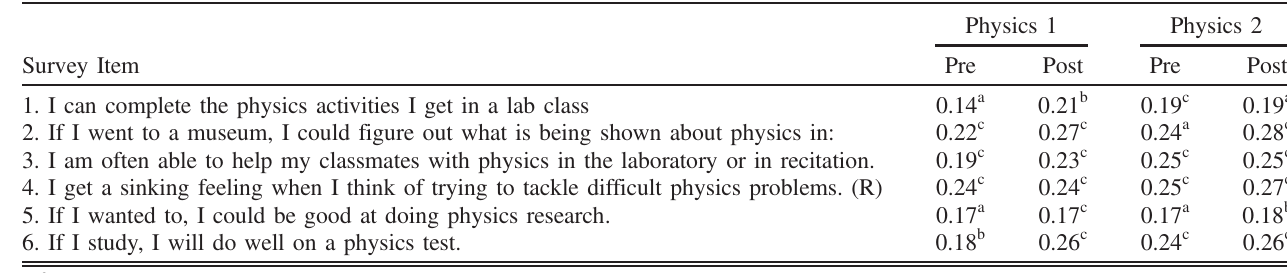
TABLE IX. Gender effect β 1 values for each self-efficacy question at pretest and post-test in physics 1 and physics 2 courses. R indicates that the survey item was reverse